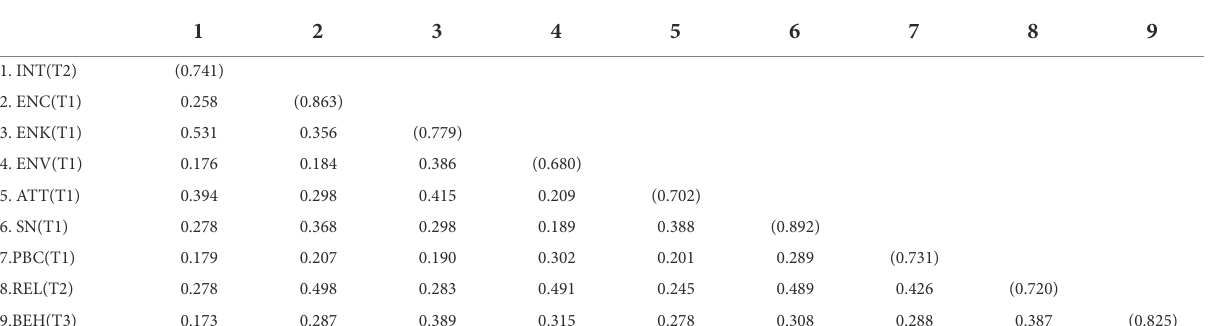
TABLE 2 Results regarding discriminant validity: aggregate.